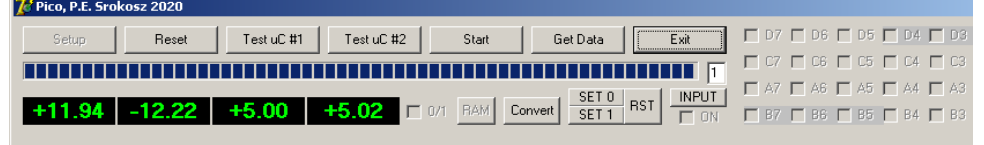
Figure 12. The application window of the software that controlled the parameters of the generated impulses.